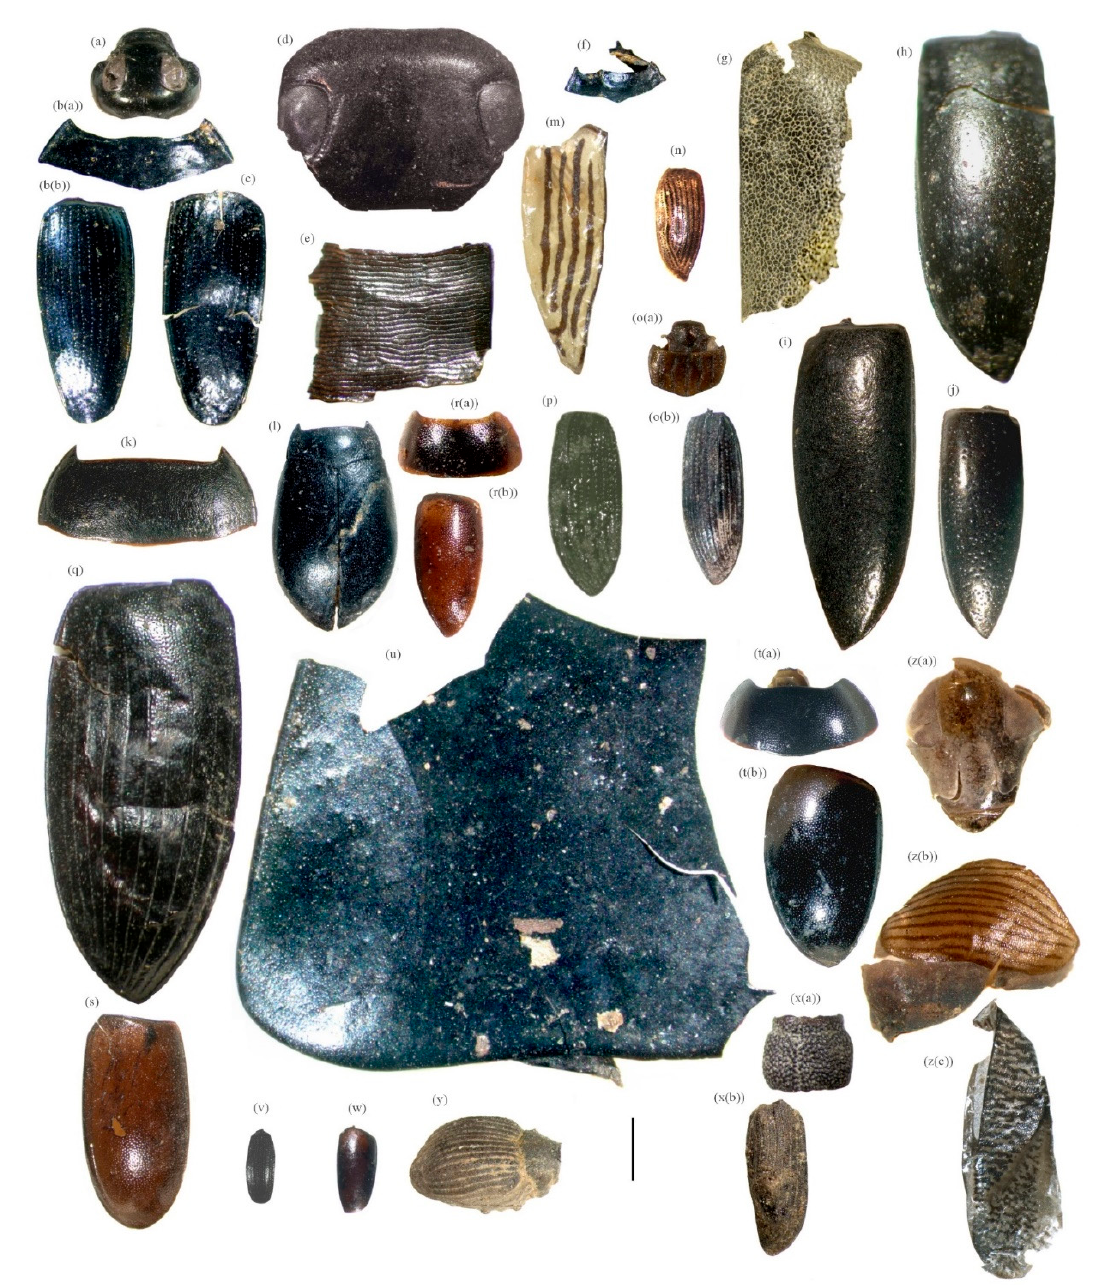
Figure 10. Remains of aquatic insects who can migrate from the water: ( a )— Gyrinus sp. ( b )— Gyrinus